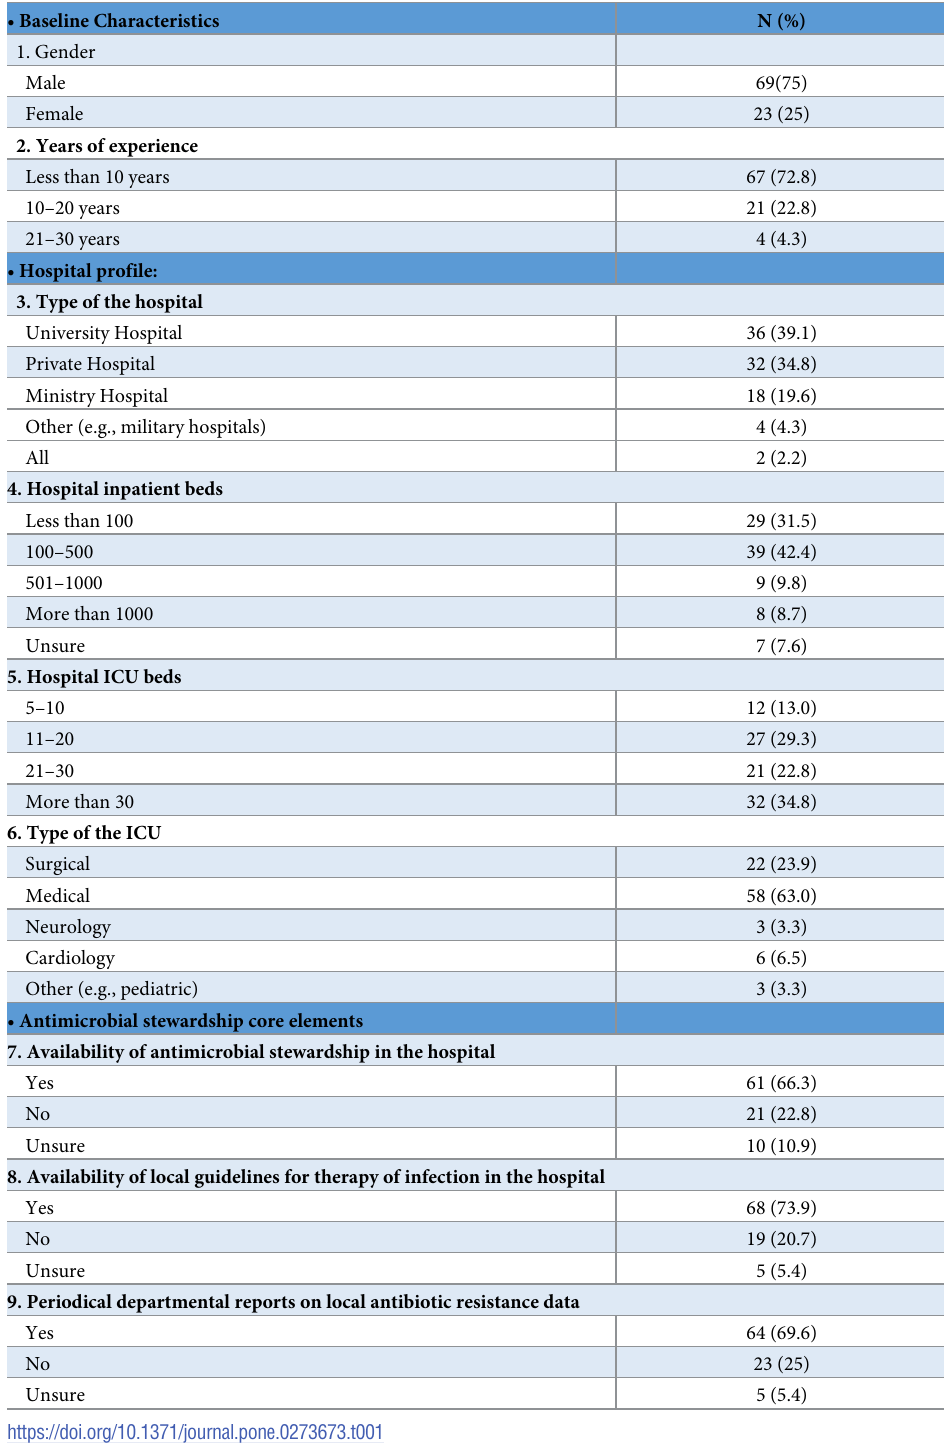
Table 1. Baseline characteristics of the participants, hospital profiles and antimicrobial stewardship core